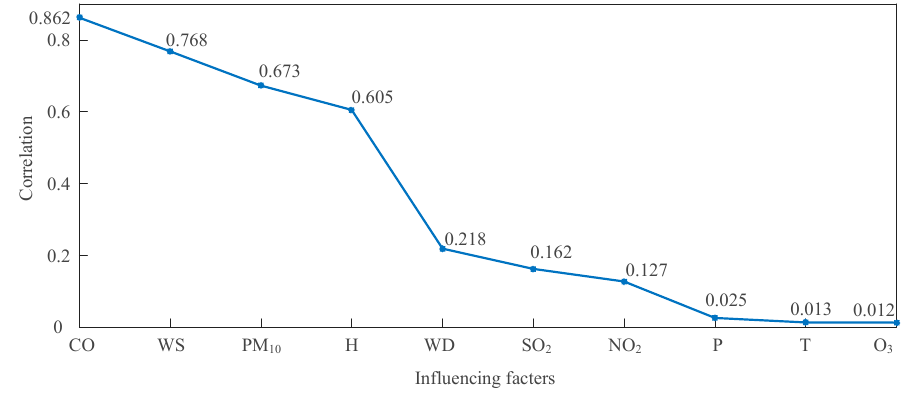
ff erent variables and PM